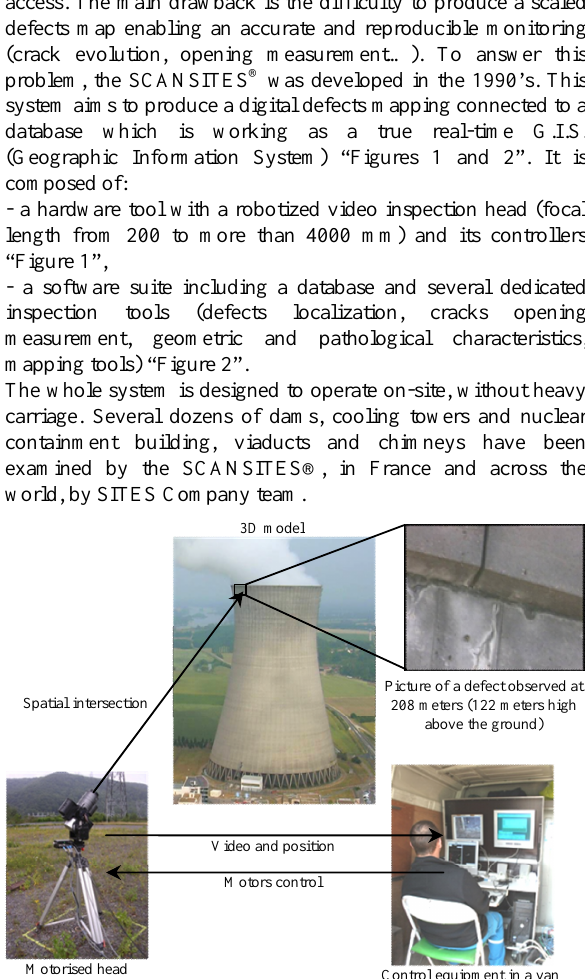
Control equipment in a Figure 1. SCANSITES ® in operation